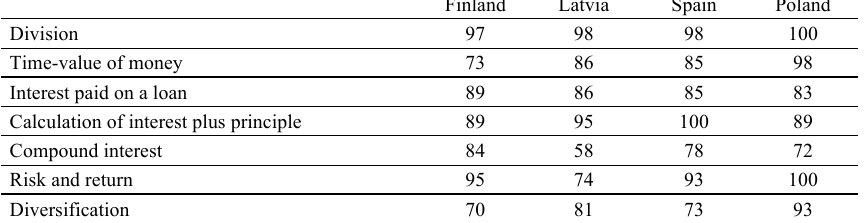
Table 2. Young customers’ financial knowledge (% of correct